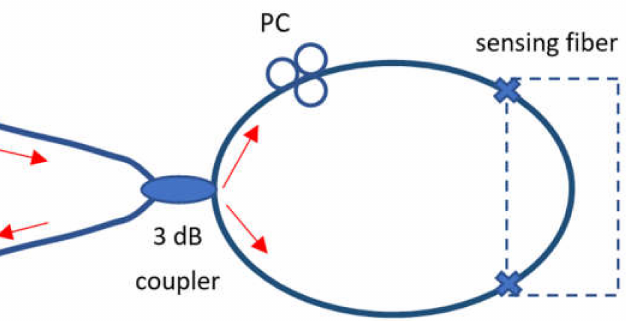
Figure 4. Schematic of FOSI based on Sagnac interferometer indicating the sensing part which is usually a specialty fabricated